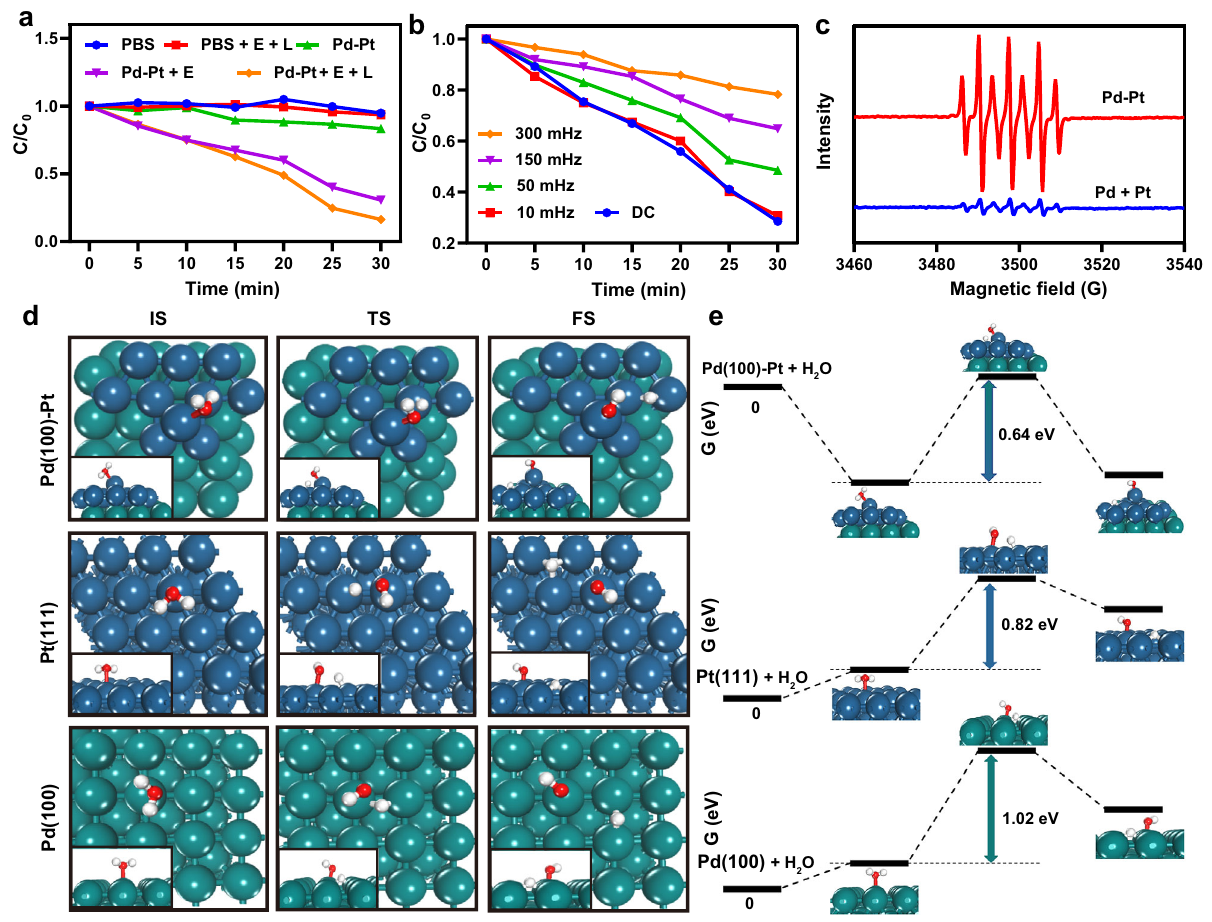
Fig.3|Electro-drivencatalyticperformanceofPd-Ptnanosheets.a Degradation behaviors of MB under different treatments. b Degradation rates of MB under AC electric fi eld with different frequencies or DC fi eld in the presence of Pd-Pt nanosheets. c ESR spectra of the system with Pd-Pt nanosheets and the simple mixture of Pd and Pt nanoparticles, respectively employing DMPO as the spin-